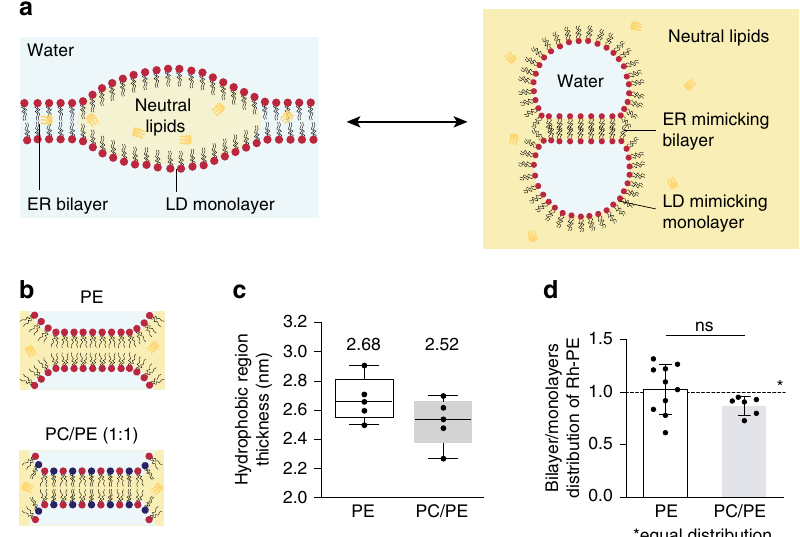
Fig. 1 Characterization of droplet interface bilayers. a Schematic representation of the ER phospholipid bilayer contiguous with the monolayer of a nascent LD (left side); the corresponding DIB system reproducing contiguous bilayer and monolayers is shown on the right side. The water phase is represented in light blue and the oil phase in yellow (neutral lipid, e.g. triglycerides (TG)). b Drawings of a DIB bilayer of DOPE (top) and DOPC/DOPE (1:1) (bottom). c The thickness of the hydrophobic region of the DIB bilayer in DOPE (white) and DOPC/DOPE (1:1) (gray) is determined by capacitance measurement. Results are shown as box-plots (box limits, upper and lower quartiles; middle line, median; whiskers, minimum and maximum value; the mean is indicated) from n = 5 independent experiments. Each point is represented as a black dot. d Distribution of Rh-PE between the bilayer and the monolayers in DOPE (white) and DOPC/DOPE (1:1) (gray) DIBs. The results are the mean ± SD of respectively n = 10 and n = 5 independent measurements. Each point is represented as a black dot. Signi fi cance was determined by Welch ’ s t -test (unpaired parametric test, two-tailed p -value) and is indicated by ns (not signi fi cant): p > 0.05. Source data are provided as a Source Data fi